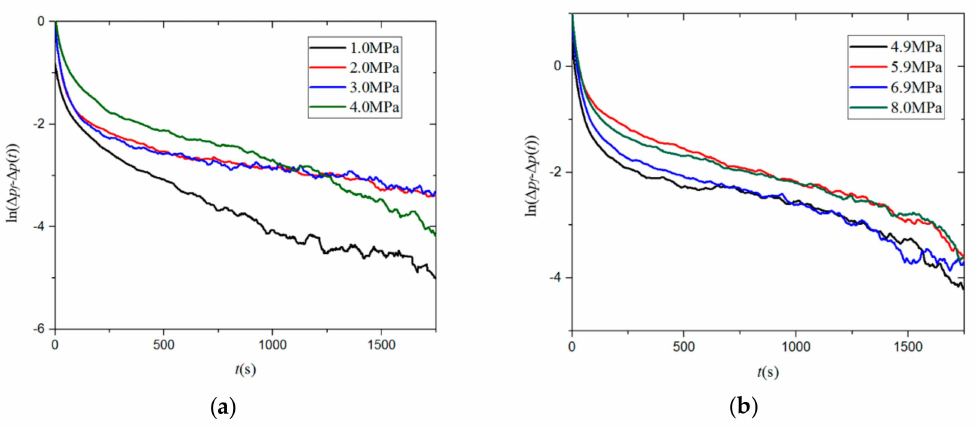
Figure A2. Logarithmic pressure decay curve, ln( ∆ p f - ∆ p( t )), for shale particle sample 1 under pressures of 1–8 MPa. ( a ) average pore pressure under 1–4 MPa; ( b ) average pore pressure under 5–8 MPa.